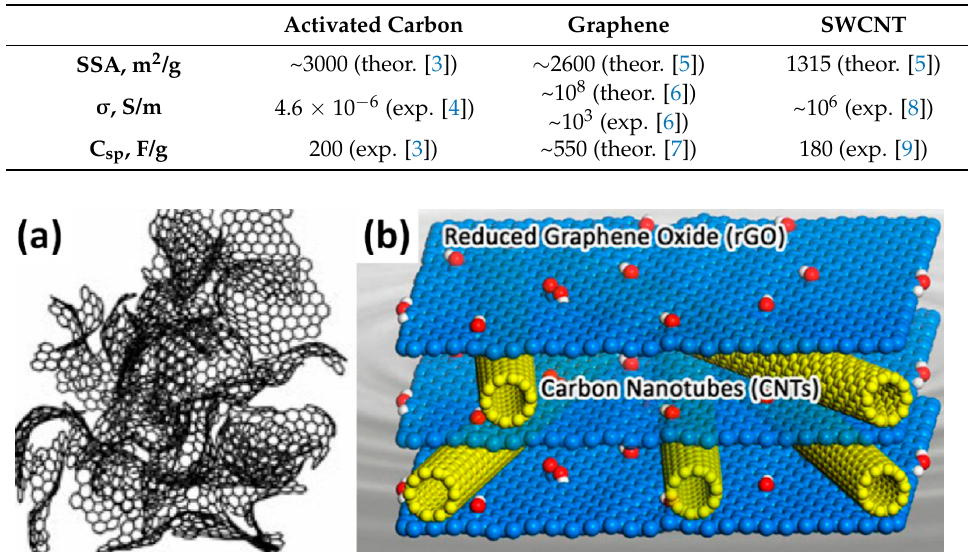
Figure 1. Model of activated carbon based on fullerene-like elements ( a ) (Reproduced with permission of [2]. Copyright Royal Society of Chemistry, 2007) and schematic model of reduced graphene oxide (rGO)/carbon nanotubes (CNT) hybrid structure ( b ) with blue and yellow spheres corresponding to carbon atoms of rGO and CNT, respectively, as well as white and red spheres representing hydroxyl group hydrogen and oxygen atoms, respectively (Reproduced with permission of [10]. Copyright Elsevier, 2015).